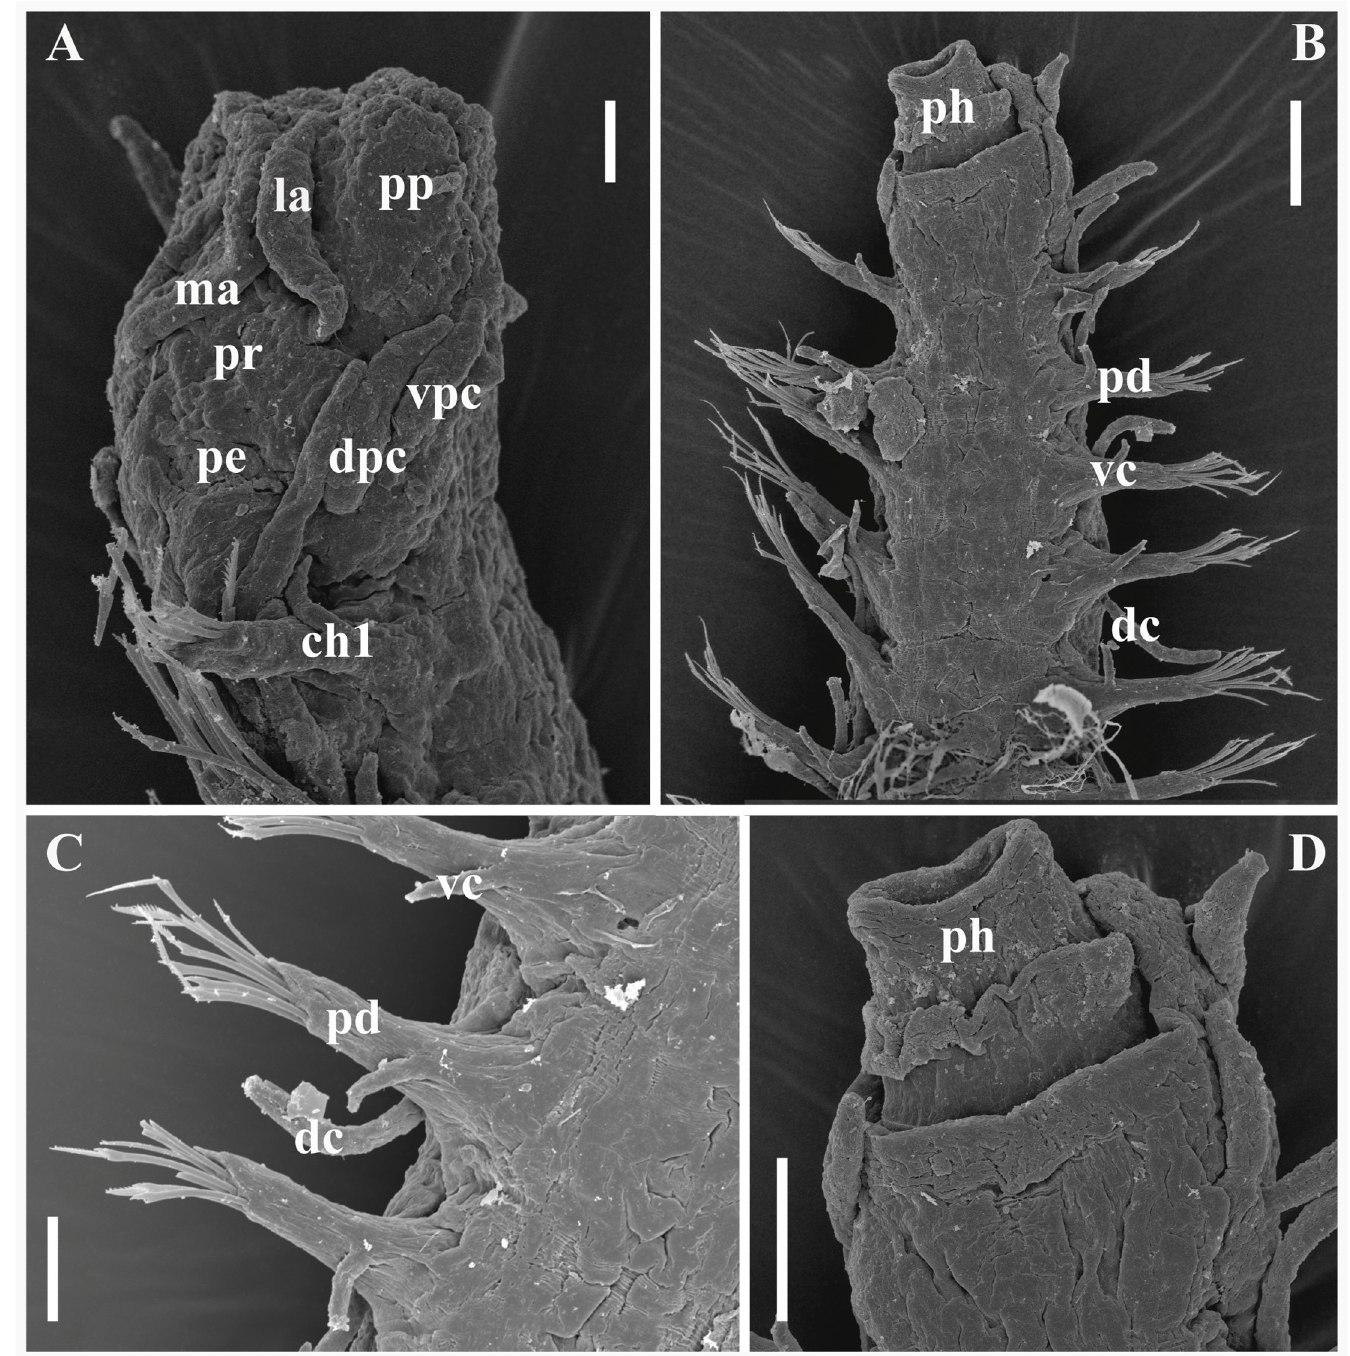
Fig 12. Salvatoria ypsiloides n. sp., SEM. (A). Anterior body, dorso-lateral view; (B). Anterior body, ventral view; (C). Anterior parapodia, ventral view; (D). Prostomium and peristomium (pharynx everted), ventral view. ch1 –chaetiger 1; dc –dorsal cirrus; dpc –dorsal peristomial cirrus; la –lateral antenna; ma –median antenna; pd –parapodium; pe –peristomium; ph –pharynx (everted); pp –palps; pr –prostomium; vc –ventral cirrus; vpc –ventral peristomial cirrus. Scale bars: A, D, 10 μ m; B, 50 μ m; C, 20 μ m.